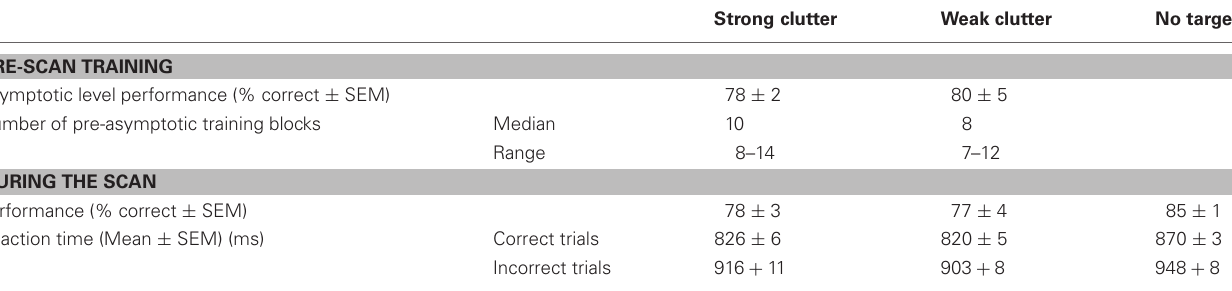
Table 1 | Behavioral